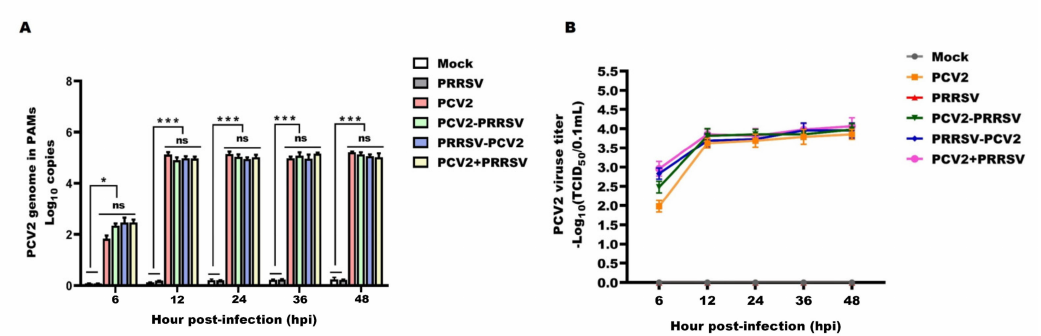
Figure 3. PCV2 viral load of different infection groups. PAMs in the PCV2 alone group (PCV2), the PRRSV alone group (PRRSV) and the PCV2 and PRRSV co − infected groups (PCV2 − PRRSV, PRRSV − PCV2 and PCV2 + PRRSV) were inoculated with PRRSV and/or PCV2 at a MOI of 1, respectively. PAMs in the mock group were inoculated with equal RPMI − 1640 medium. Then, PAMs in these groups were collected at 6 h, 12 h, 24 h, 36 h and 48 h post − infection, respectively. ( A ) The levels of viral DNA were measured by RT − qPCR. ( B ) The viral titers of PCV2 in the cell culture supernatants were analyzed by TCID 50 . Data are expressed as means ± SD of three independent experiments. Statistically significant differences for the PCV2 and PRRSV co − infected groups vs. the mock − inoculated group and the PRRSV alone group (* p < 0.05, *** p < 0.001). No significant differences were observed for the PCV2 alone group vs. the PCV2 and PRRSV co − infected groups